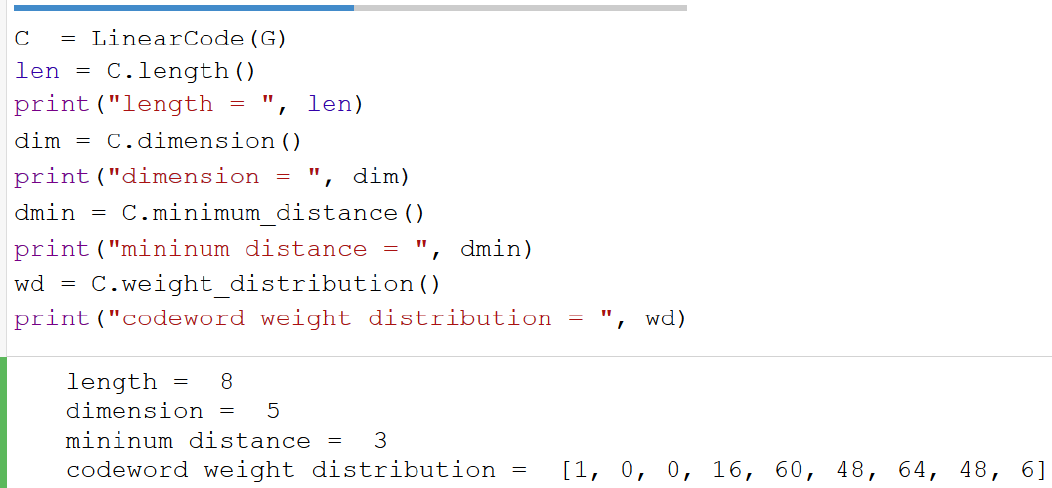
Figure 12. Information about the code.